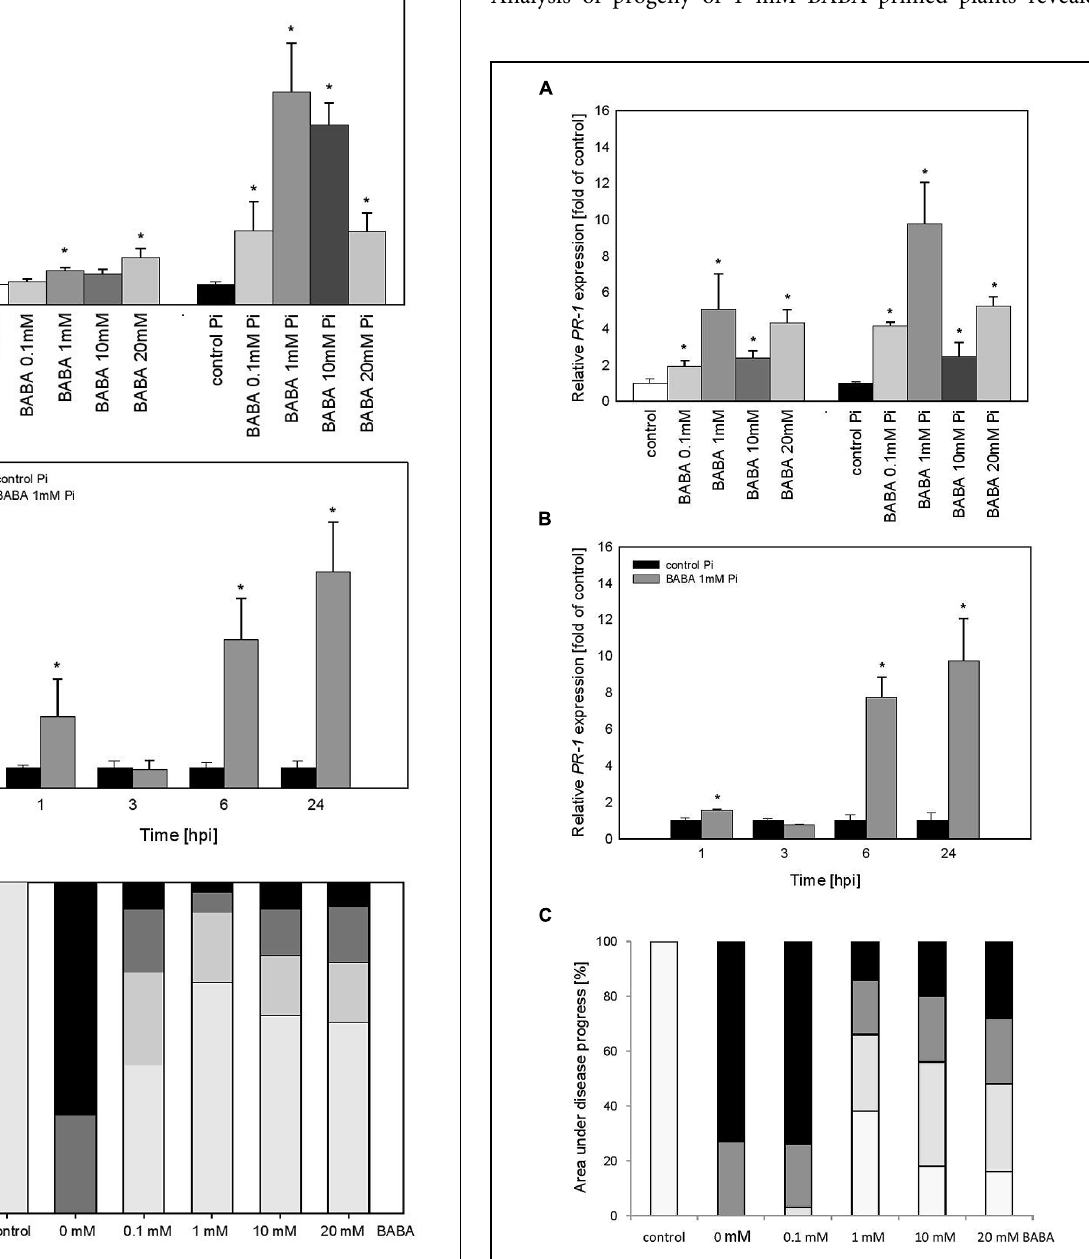
FIGURE 4 | PR-1 gene transcript accumulation in progeny lines of immunized potato plants (B B stage) -offspring received from the BABA-treated parental line with use of tubers. (A) After induction of B 0 -originated plants with BABA (left bars) and 24 h after inoculation of previously immunized plants (right bars), (B) a time-dependent analysis of PR-1 gene expression in P. infestans -inoculated plants obtained from the tubers of plants exposed to 1 mM BABA (in B 0 stage), (C) disease development index at 7 dpi in the BABA-treated parental line with use of tubers, ∗ significantly different from control leaves, P < 0.05. Values represent means of data ± SD of at least three independent experiments, each with at least three biological